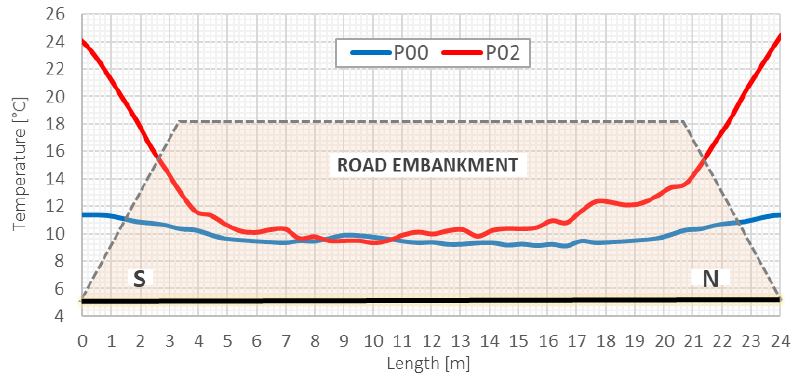
Figure 22. Temperature distributions along section A in session P00 and P02 , measured using the 3DSensor and DFOS technique based on Raman scattering (width and height of embankment are drawn on a different scale for clear presentation).